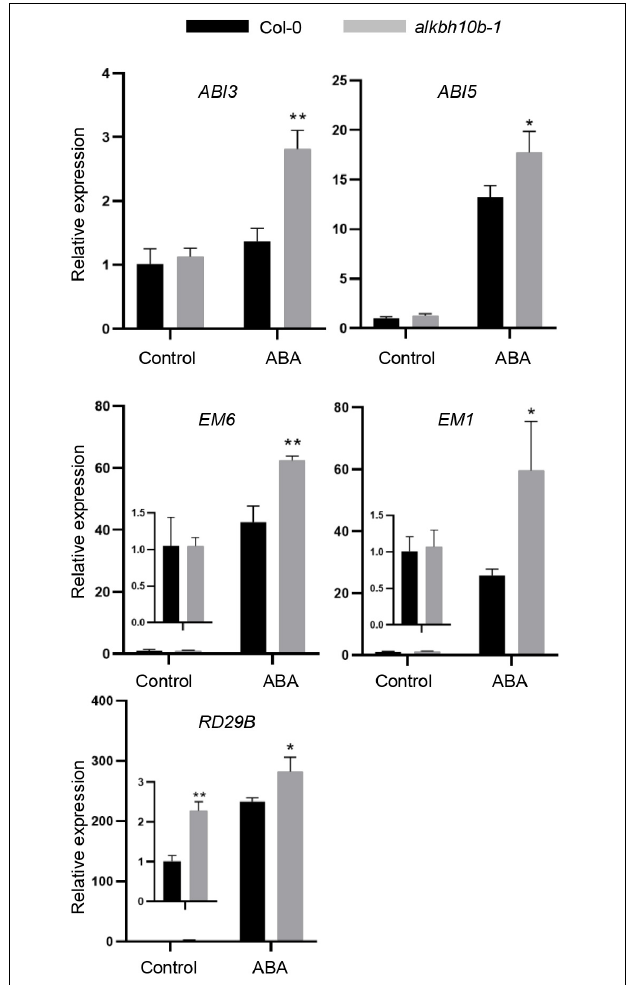
FIGURE 5 | ALKBH10B regulates the expression of ABA response genes. The expression patterns of ABA signaling-related ABI3, ABI5, and RD29B, and embryogenesis-related EM1 and EM6 were determined in seven-day-old seedlings treated with 50 µ M ABA for 3 h. The transcript level of each gene was normalized to that of At2G28390 , and the relative level of each gene in mock-treated Col-0 was set to 1. Values are mean ± SD of three replications. Asterisks indicate statistically significant differences (* P < 0.05; ** P < 0.01; Student’s t